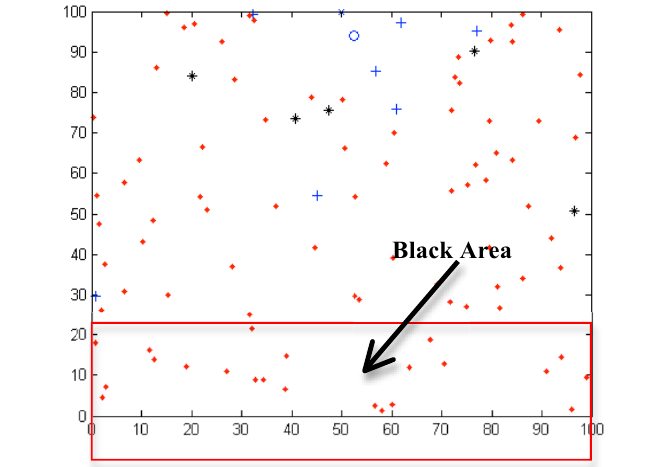
Fig. 5. Simulation with SEP